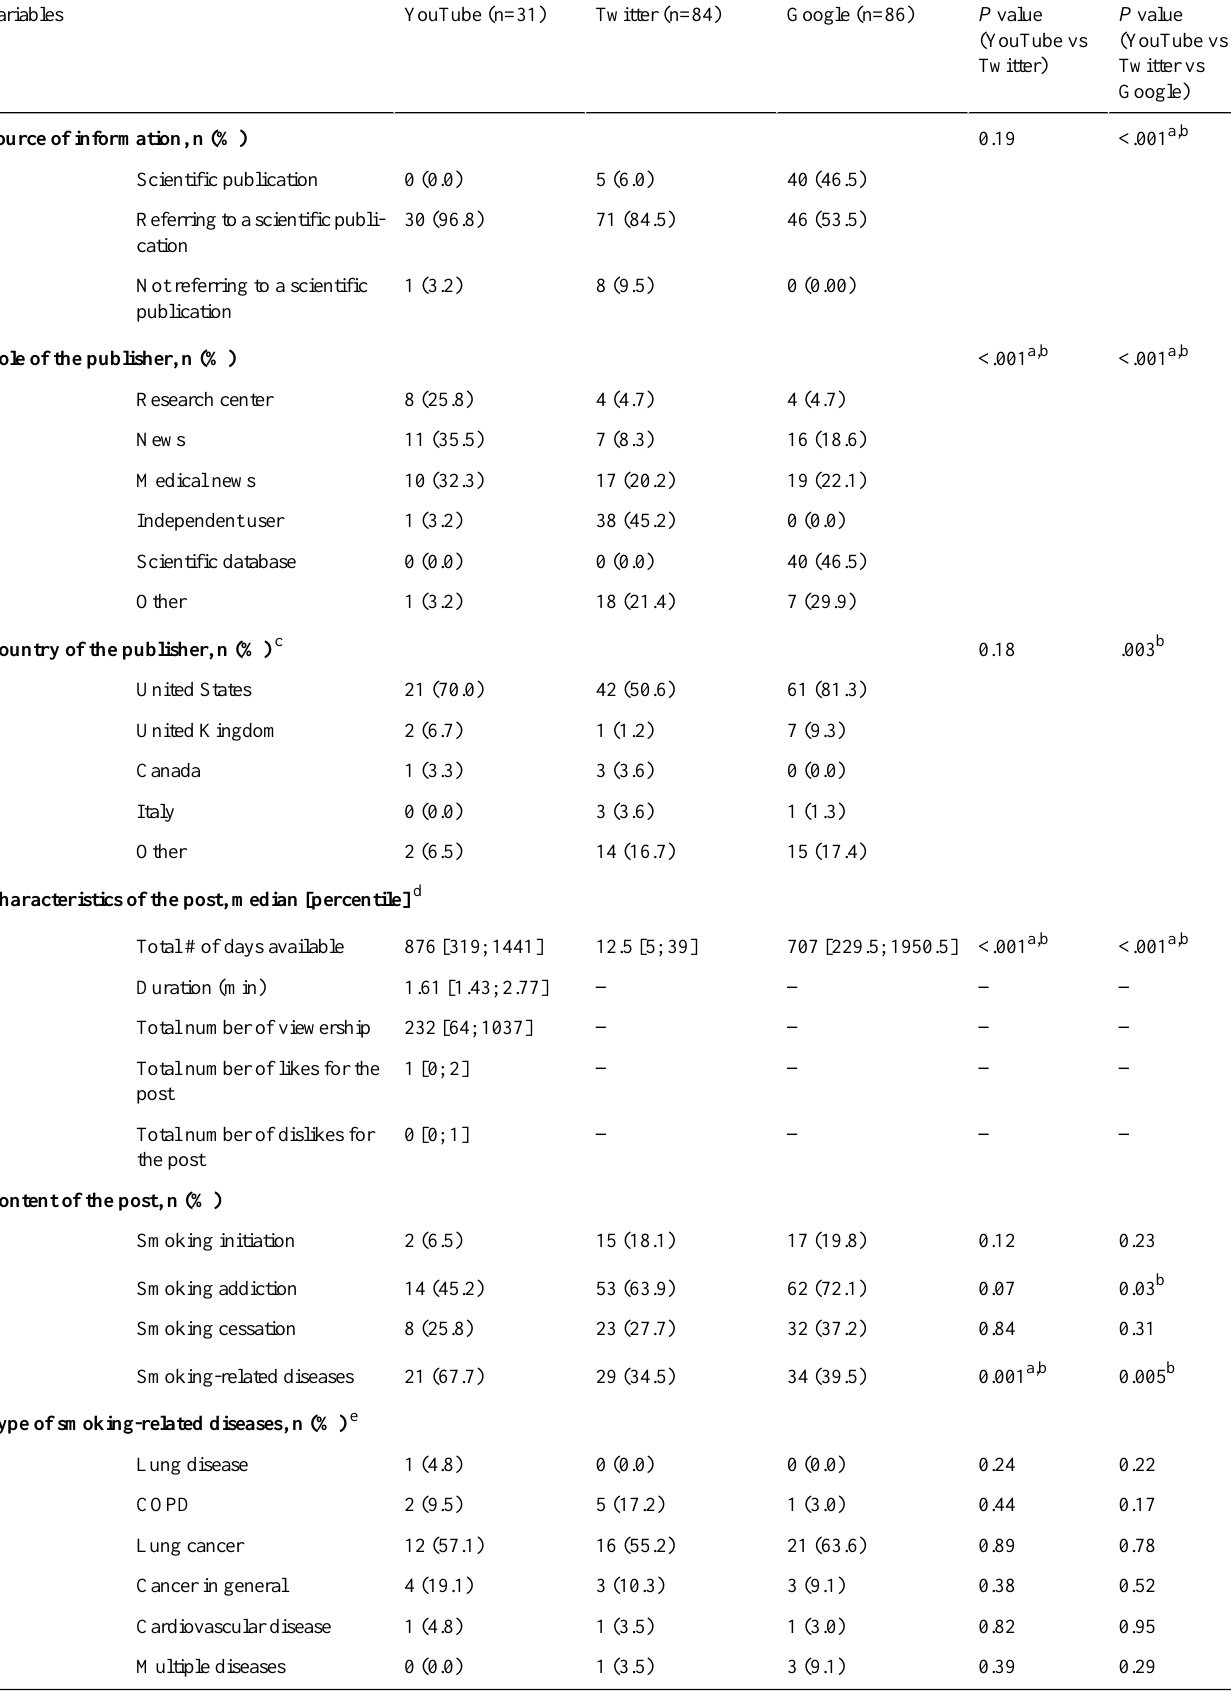
Table 1. Characteristics of posts from YouTube and Twitter ( P values from Pearson